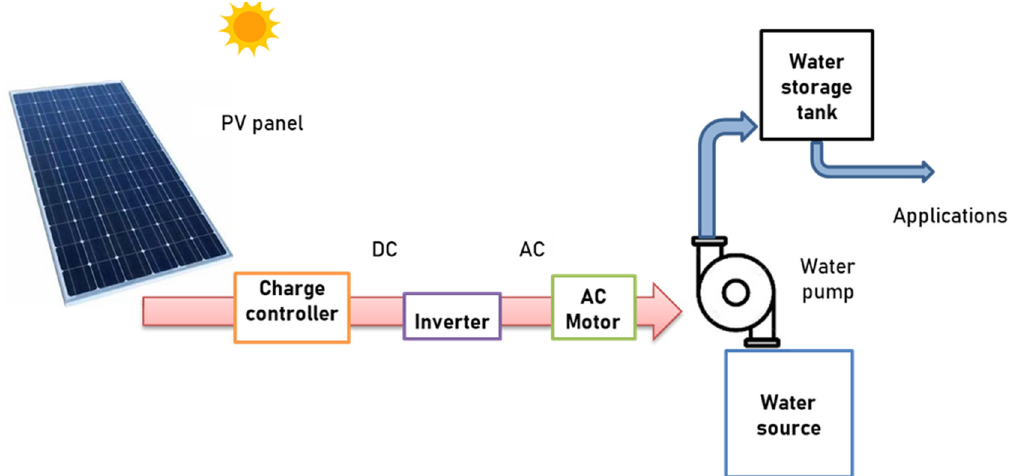
Figure 3. Continuous flow of a solar-powered water pump system.